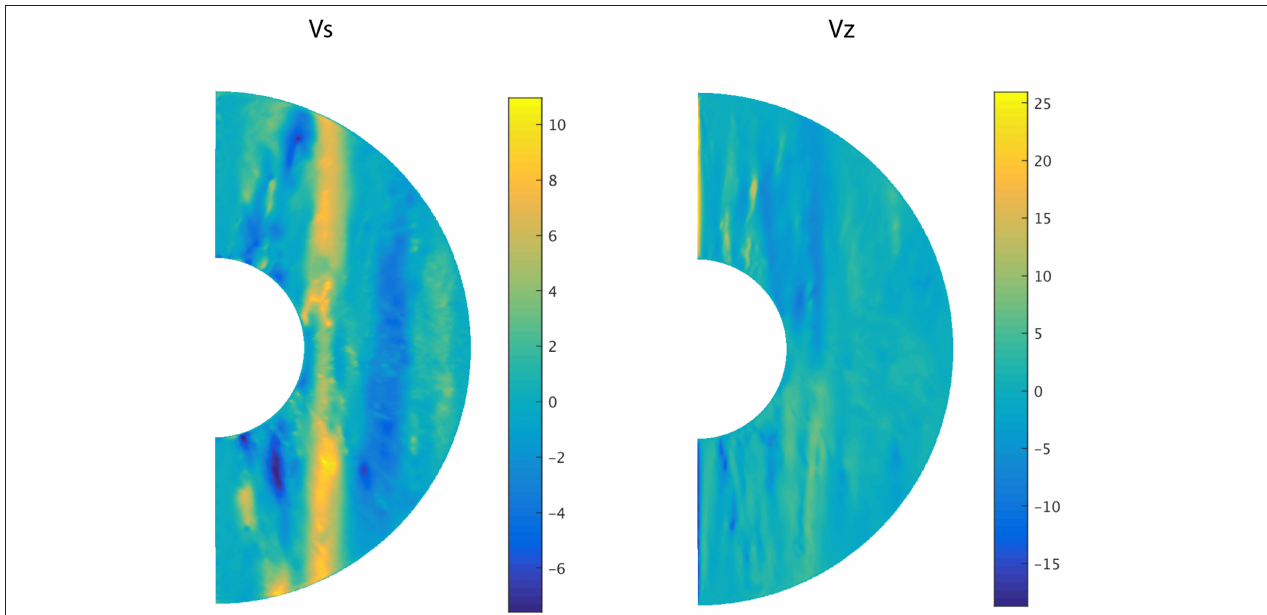
FIGURE 6 | Azimuthal section of the velocity perpendicular to (Vs) and parallel to (Vz) the rotation axis, for case 8 at time t